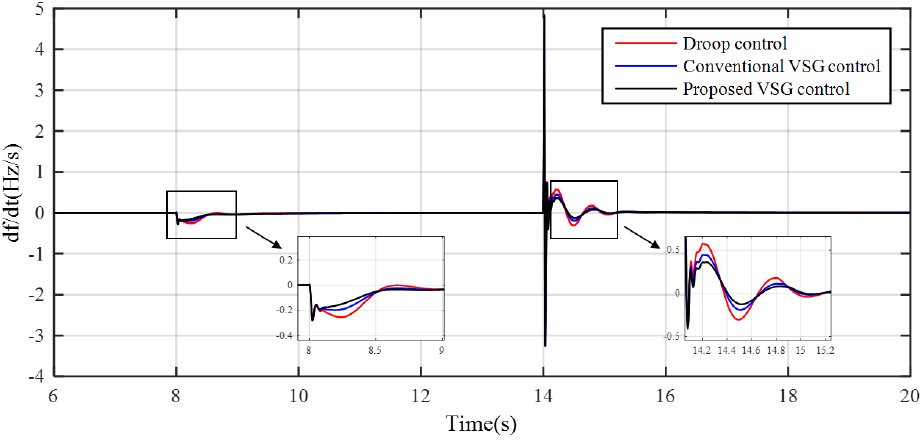
Figure 21. Derivative component of system frequency.